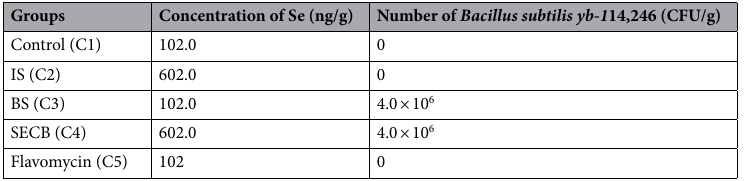
Table 2. Concentration of selenium and number of Bacillus subtilis yb-1 14,246 in Groups. Inorganic sodium selenite (IS), Bacillus subtilis yb-1 14,246 (BS), Selenium-enriched Bacillus subtilis yb-1 14,246 (SEBS).